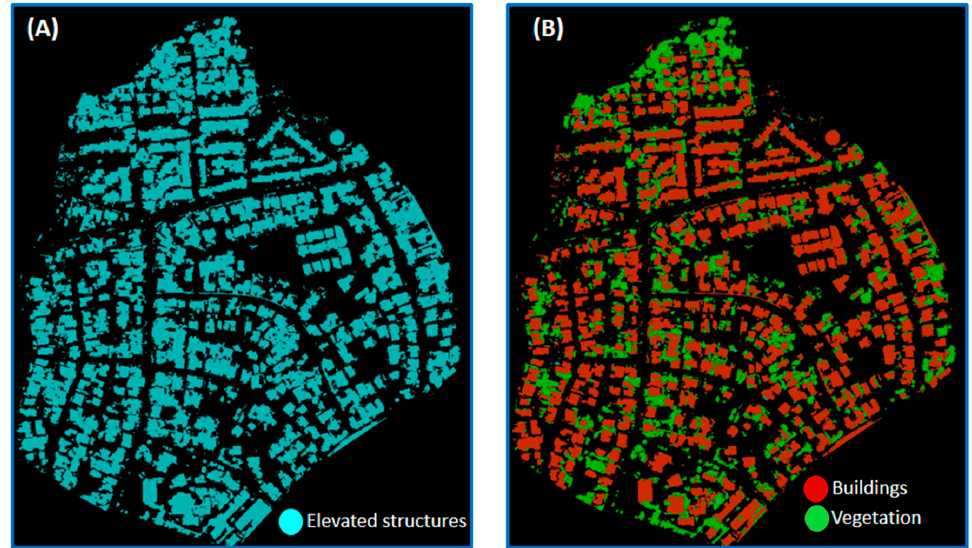
Figure 5. ( A ) Classification of all elevated structures, ( B ) separation of buildings and vegetation. Table 5. Confusion matrix for object-based image classification.